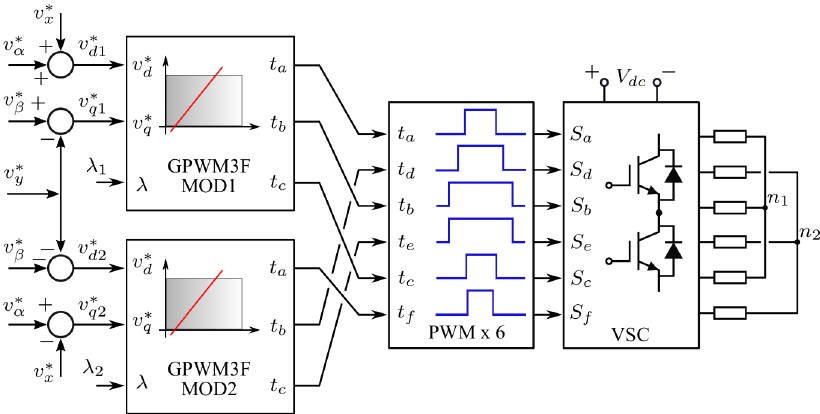
Figure 2. Generalised pulse width modulation (PWM) for asymmetrical six-phase